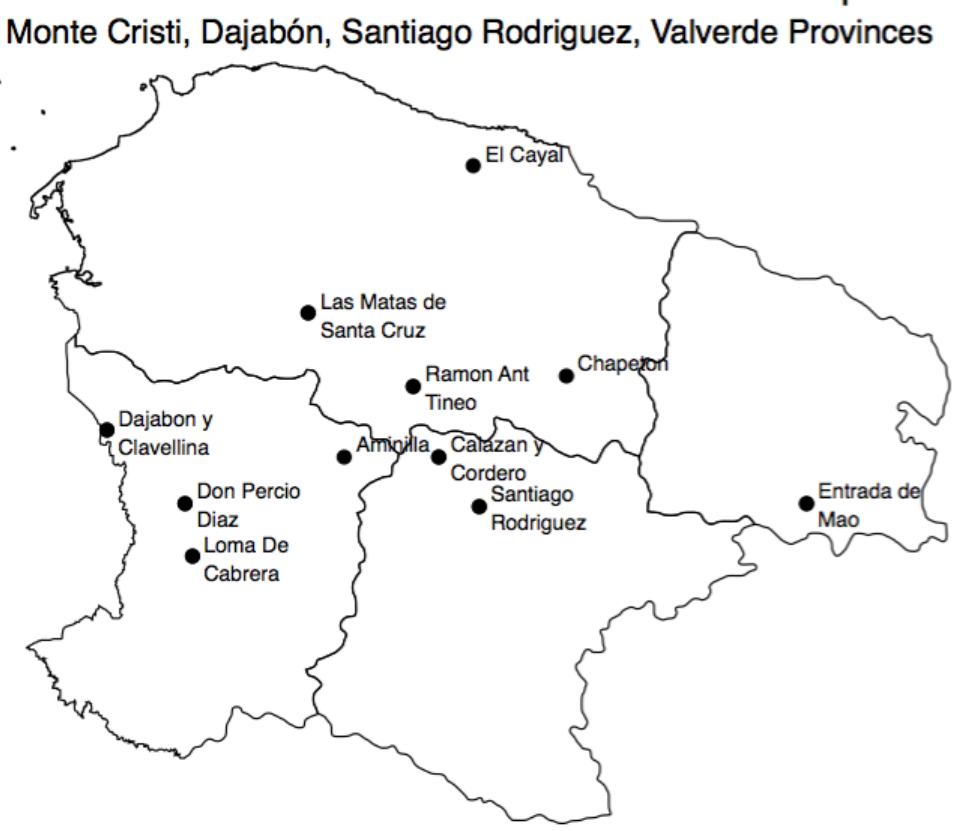
Figure 2. Location of Experiment.